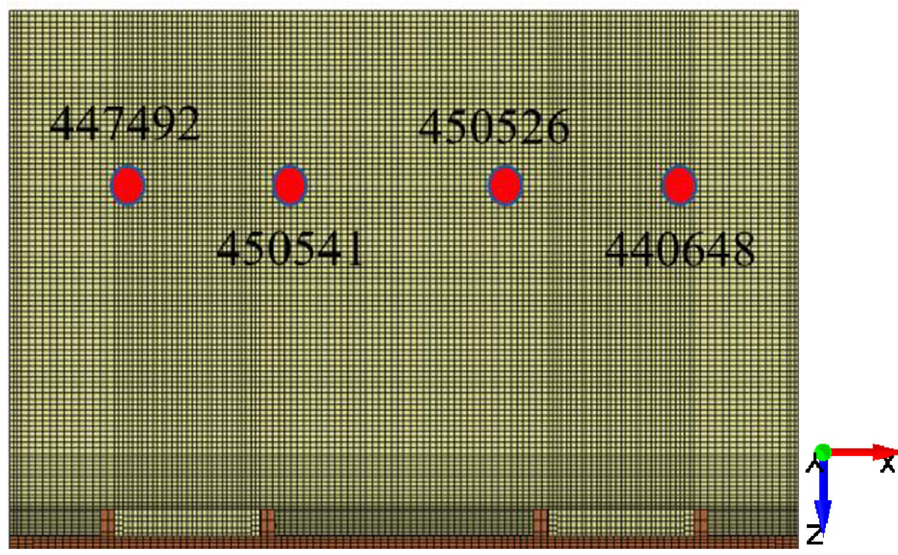
Fig 11. Four nodes on the tail